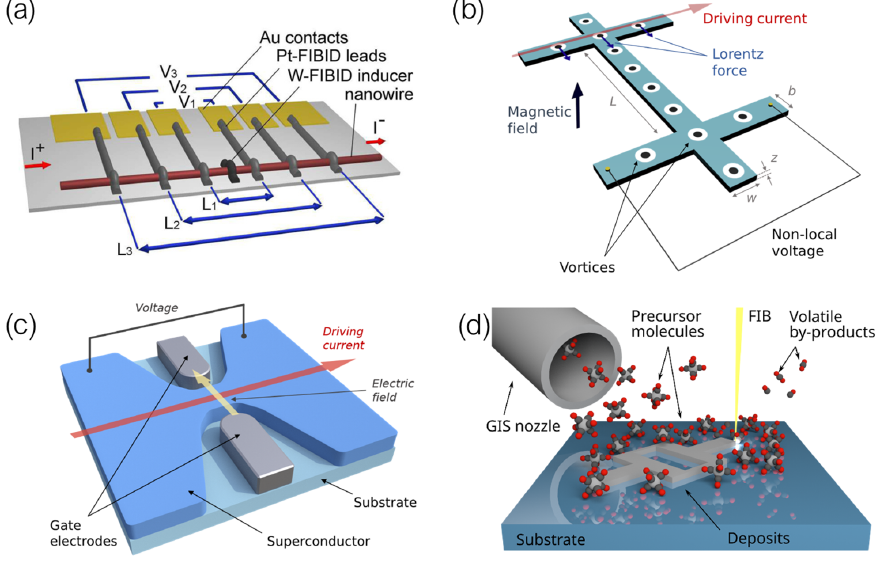
Figure 9. Summary of selected reported phenomena observed in Ga + FIBID-grown W-C nanos- tructures outlined in this review: ( a ) Superconducting proximity effect (reprinted from [99],